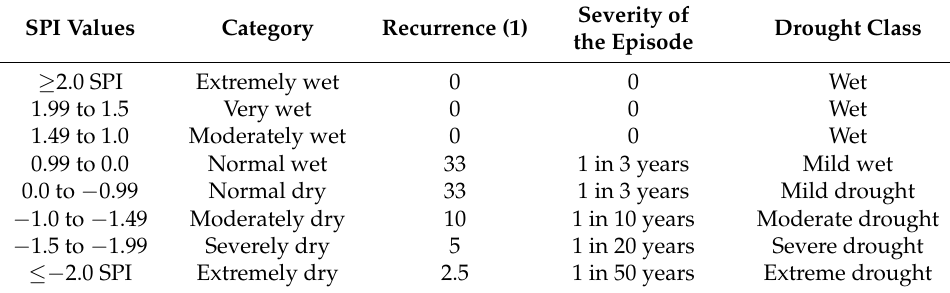
Table 6. Normalized Precipitation Index (SPI) values and drought probability of